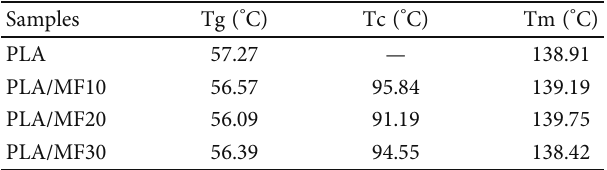
Table 7: DSC analysis of PLA/MF composites.